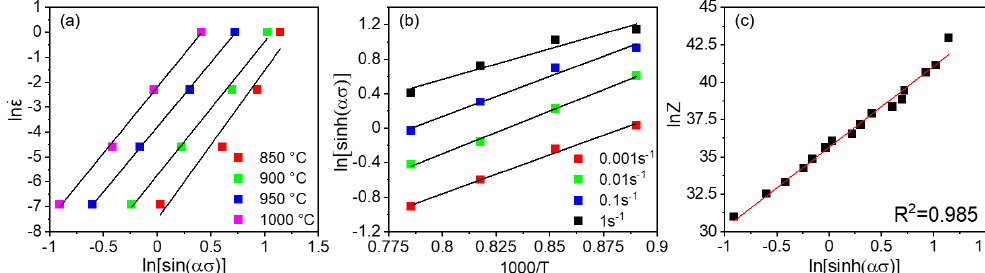
Figure 4. The relationship and linear fitting between ( a ) ln 𝜀(cid:4662) vs ln[sin( ασ )], ( b ) ln[sinh( ασ )] vs (1/T), and ( c ) lnZ vs ln[sinh( ασ )] of the CoCrNi alloy. The hot-compression was carried out at 900, 1000, and 1100 °C with a strain rate of 0.1, 0.01, and 0.001 s − 1 .